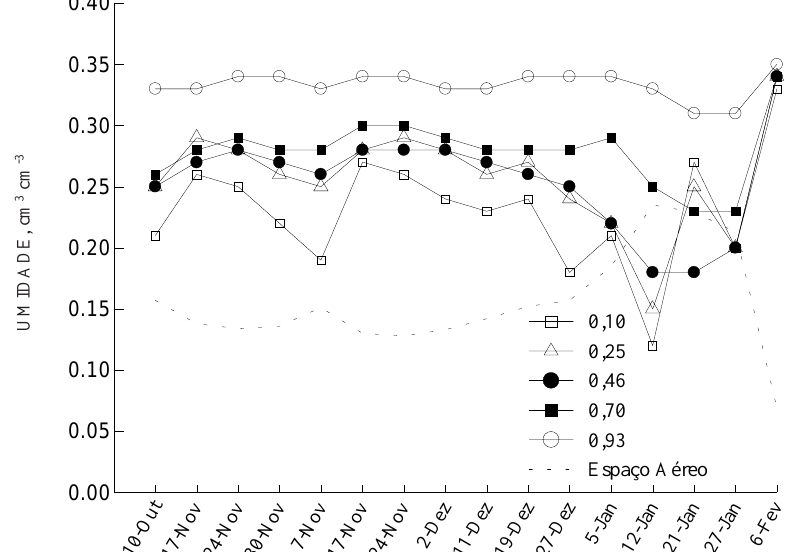
Figura 3. Variação temporal da umidade do solo determinada a 0,10, 0,25, 0,46, 0,70 e 0,93 m de profundidade e espaço aéreo na camada de 0,45 m. Cada ponto é a média das leituras dos dois perfis com horizonte A raso.